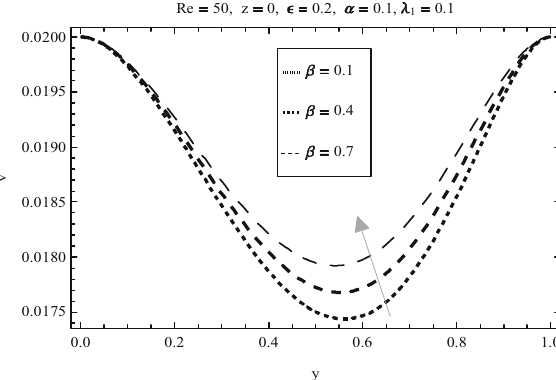
Fig. 7 Velocity component v along y for different values of β